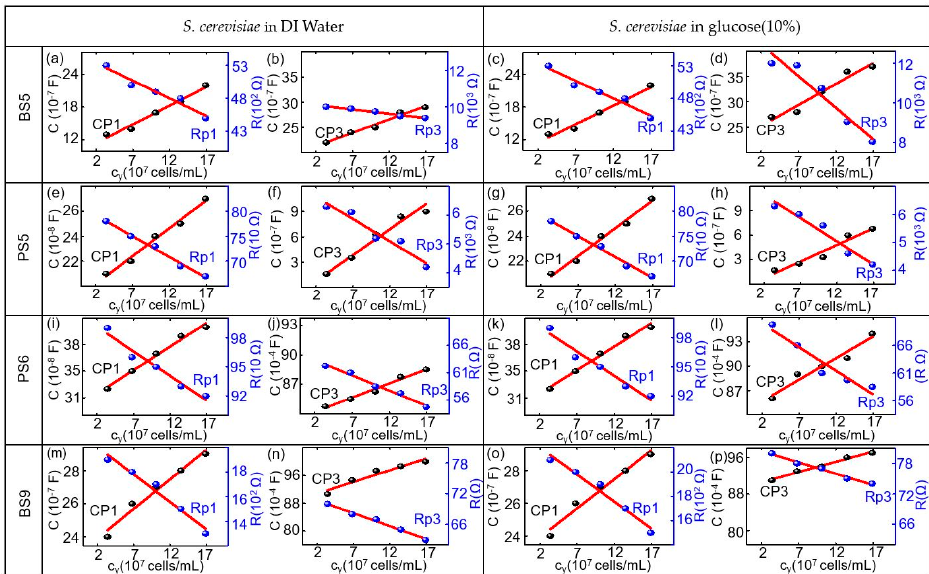
Figure 6. Modeled equivalent circuit parameters (dots) and linear fitting curve (red lines) for ( a , e , i , m ) Rp1, and Cp1 and for ( b , f , j , n ) Rp3 and CP3 of the biochip BS5,PS5,PS6,BS9 in dependence on the concentration yeast c y in units of 10 7 cells / mL in DI water and for ( c , g , k , o ) Rp1 and Cp1 and for ( d , h , l , p ) Rp3 and CP3 of the biochip BS5, PS5, PS6, BS9 in dependence on the concentration yeast c y in units of 10 7 cells / mL in the medium with 10% glucose.